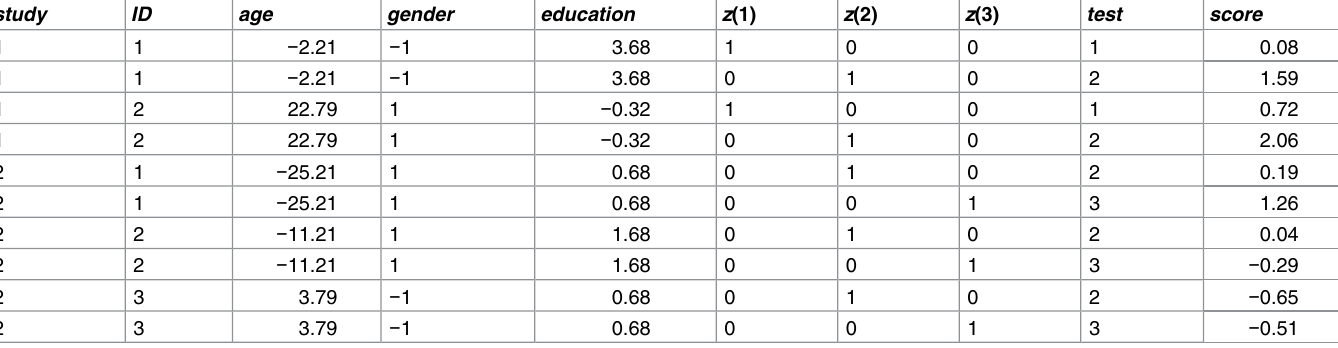
Table 2. Simulated example of a multilevel dataset with one row per test score. study indicatesstudy number; ID indicatesparticipantnumber; age , gen- der and education are backgroundvariables; z (1), z (2) and z (3) are indicatorvariables; test indicatestest numberand score indicates the score on the test with that